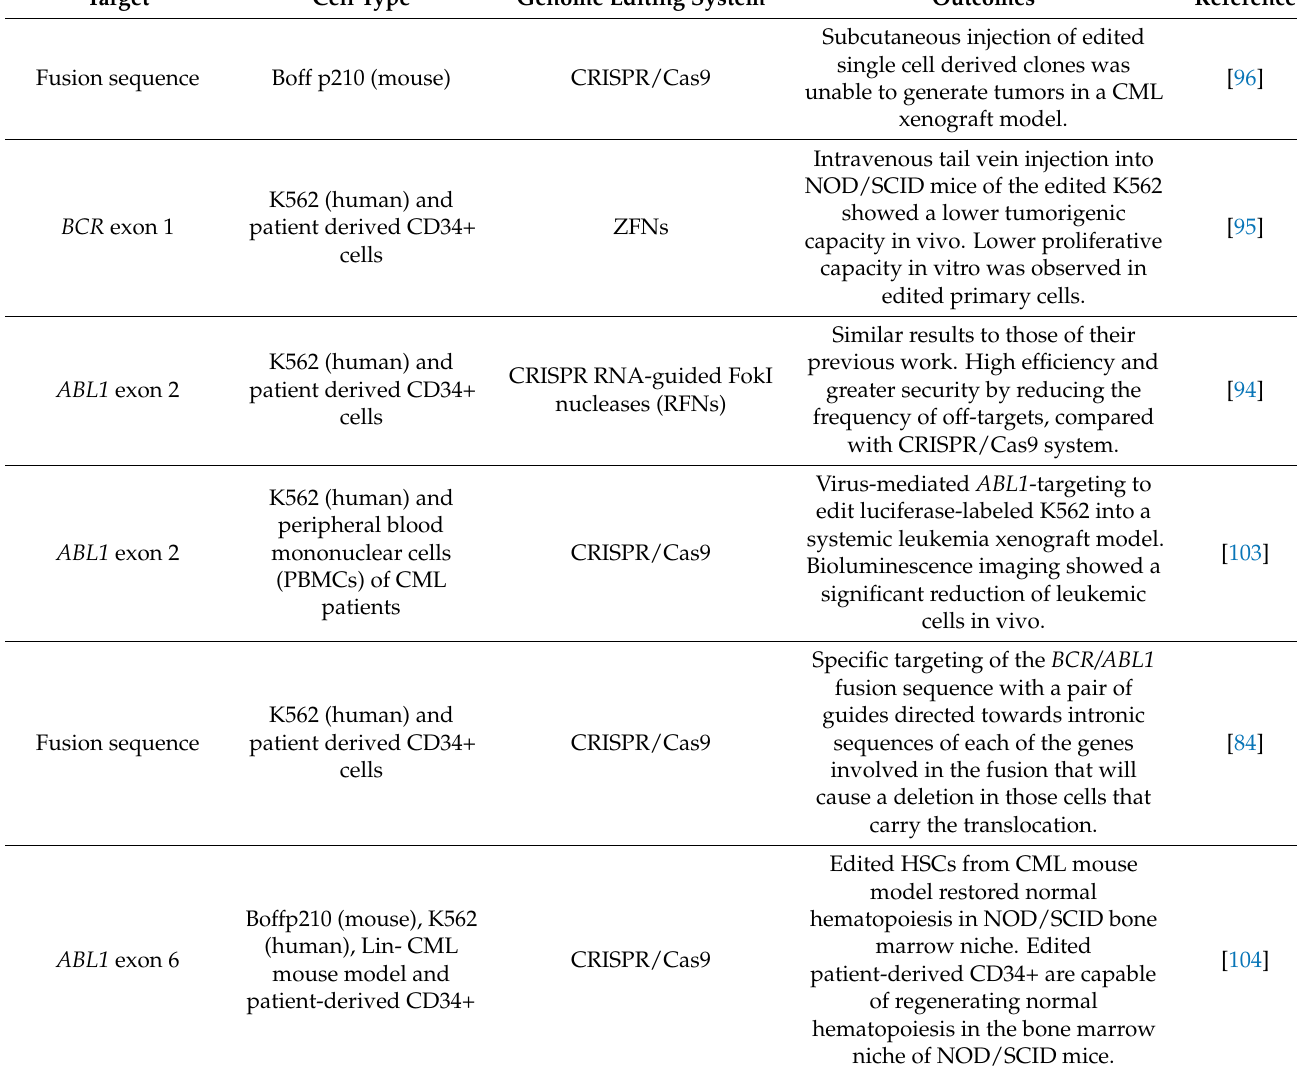
Table 1. Therapeutic strategies to disrupt the BCR/ABL1 oncogene in CML by genome-editing